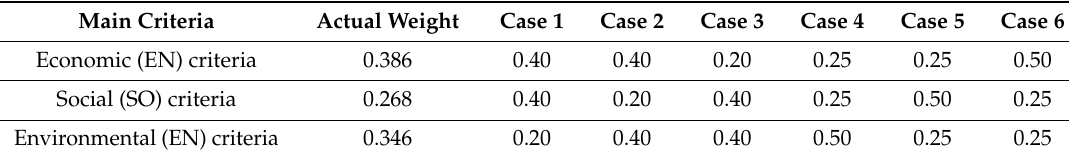
Table 9. Weights of main-criteria with actual and di ff erent cases.